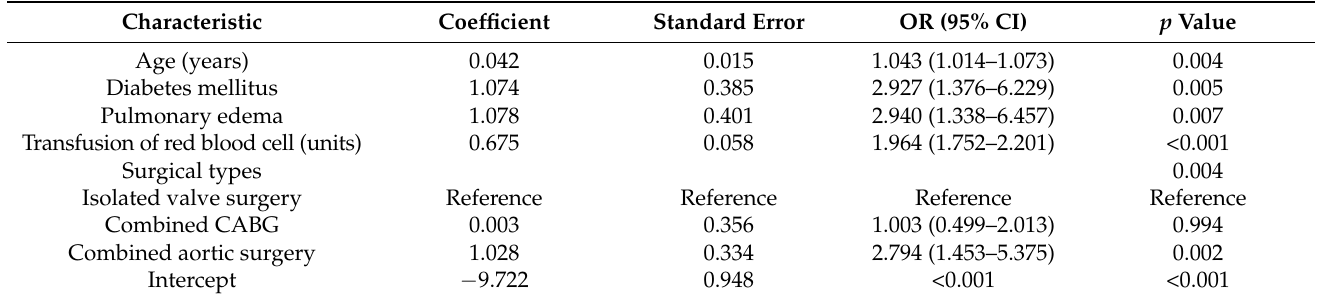
Table 2. Multivariate analysis of independent risk factors for POTs after HVS.